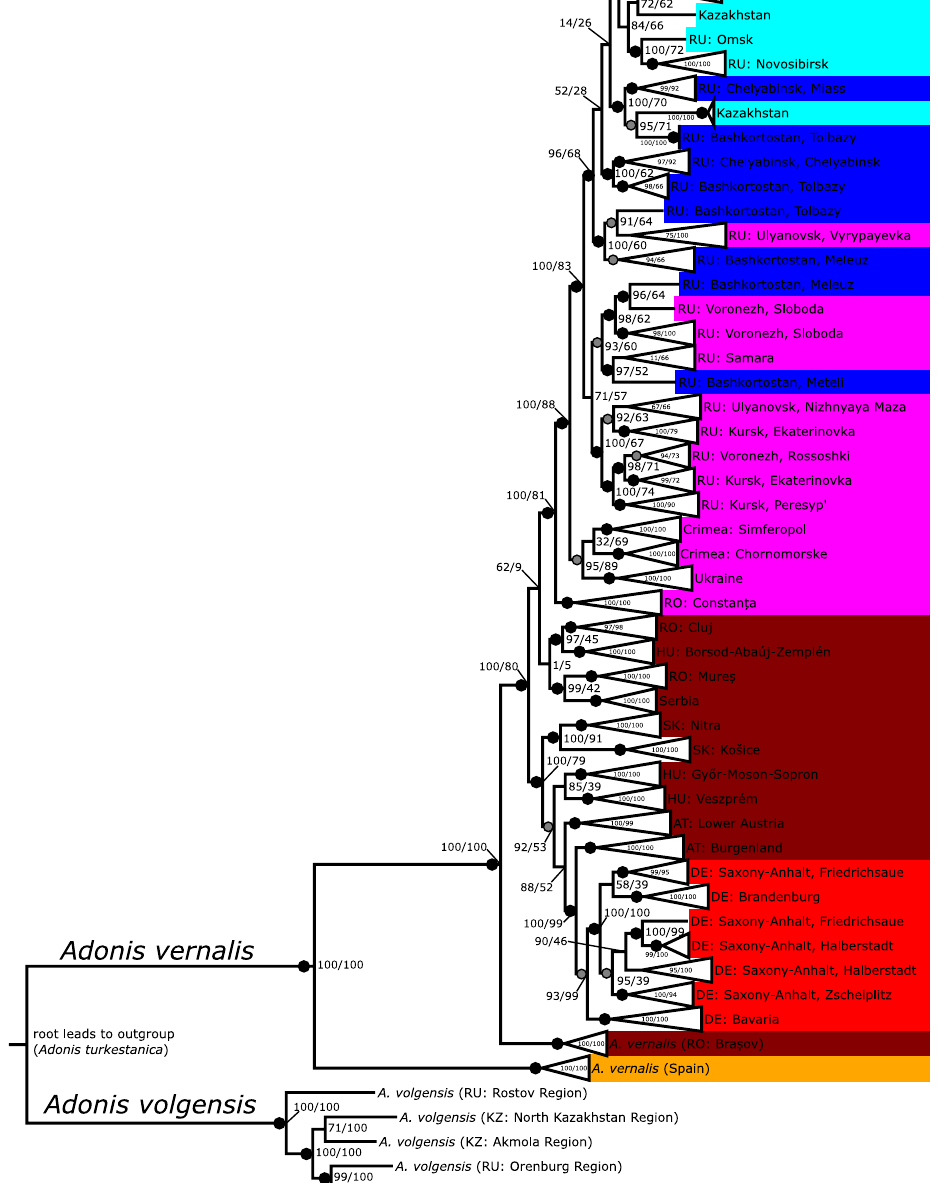
Figure 4. Maximum-likelihood analysis of GBS data based on unlinked SNPs from 23,242 loci (performed with IQ-TREE software). Values at nodes denote SH-like approximate likelihood ratio test and ultrafast bootstrapping support (aLRT/UFBoot) with 1,000 replicates each. Gray dots represent 90–95% and black dots 95–100% aLRT support of the nodes. Adonis turkestanica (truncated) was set as outgroup. Note that another species known to be closely related to A. vernalis ( A. villosa ; Supplementary Figs. S2 and S3 online) was not included in the GBS analysis. The colour coding refers to geographic groups in A. vernalis (Fig. 1, Supplementary Table S4 online): yellow = Spain, red = Germany, brown = Pannonian, pink = Pontic, blue = Southern Urals/W. Western Siberia, and turquoise = Middle/E. Western Siberia. Two-letter abbreviations are ISO alpha-2 country codes. Note that not all areas where A. vernalis occurs are equally well covered, e.g., populations from France, Italy and Switzerland are missing. The Burgenland population (Austria) is represented by two